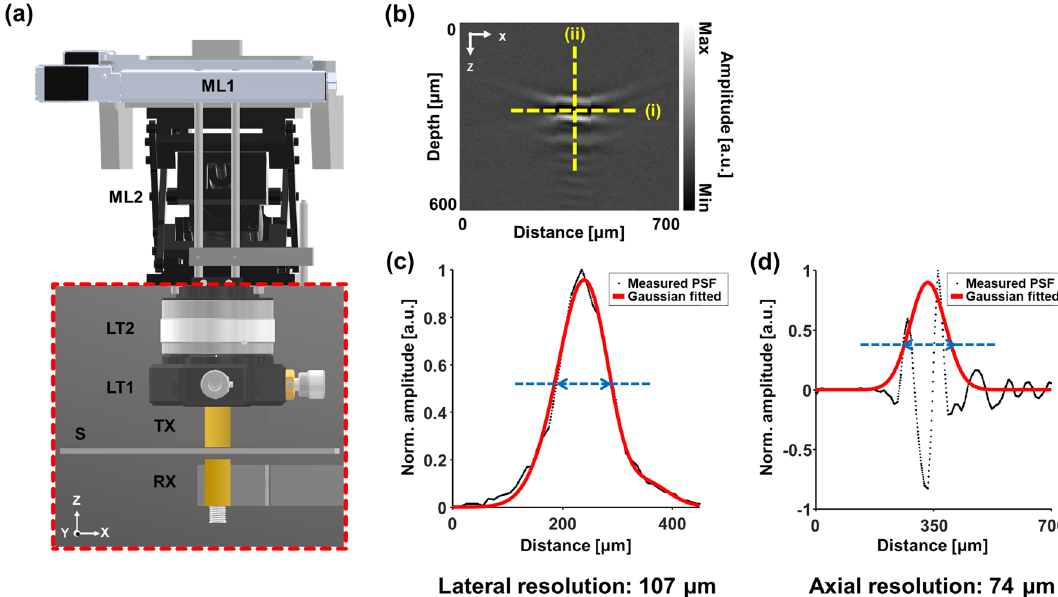
Figure 2. High-resolution ultrasound (US) imaging system. ( a ) System schematic. ( b ) US B-mode image of a steel wire with a diameter of 40 μm. ( c ) Lateral and ( d ) axial profiles cut along the dotted yellow line "i" and "ii", respectively, in ( b ). ML motorized linear stage, LT linear translator, TX transmitting transducer, RX receiving transducer, S steel sheet, PSF point spread function. (plotted by: MATLAB R2018a—https:// www. mathw orks. com/ produ cts/ matlab. html, Autodesk Inventor Professional 2020—https:// www. autod esk. com/ produ cts/ inven tor/ overv iew? us_ oa= dotcom- us& us_ si= 90f91 e34- c852- 4086- bf8f- 5727e dba52 68& us_ st= inven tor& us_ pt= INVNT OR, imported by: CXY1Q, Thorlabs Inc.—https:// www. thorl abs. com/ thorp roduct. cfm? partn umber= CXY1Q# ad- image-0, SM1ZM, Thorlabs Inc.—https:// www. thorl abs. com/ thorp roduct. cfm? partn umber= SM1ZM, ASR100B120B-T3A, Zaber Technologies Inc.—https:// www. zaber. com/ produ cts/ scann ing- micro scope- stages/ ASR/ docum ents? part= ASR10 0B120B- T3A, 8MVT188-20, Standa Ltd.—https:// www. standa. lt/ produ cts/ catal og/ motor ised_ posit ioners? item=